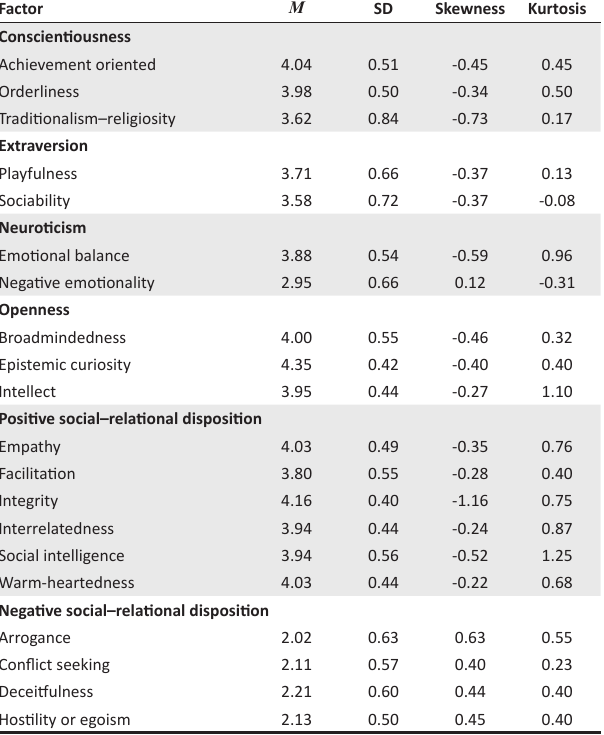
TABLE 2: Descriptive statistics of the South African Personality Inventory ( N = 3912). Factor M SD Skewness Kurtosis